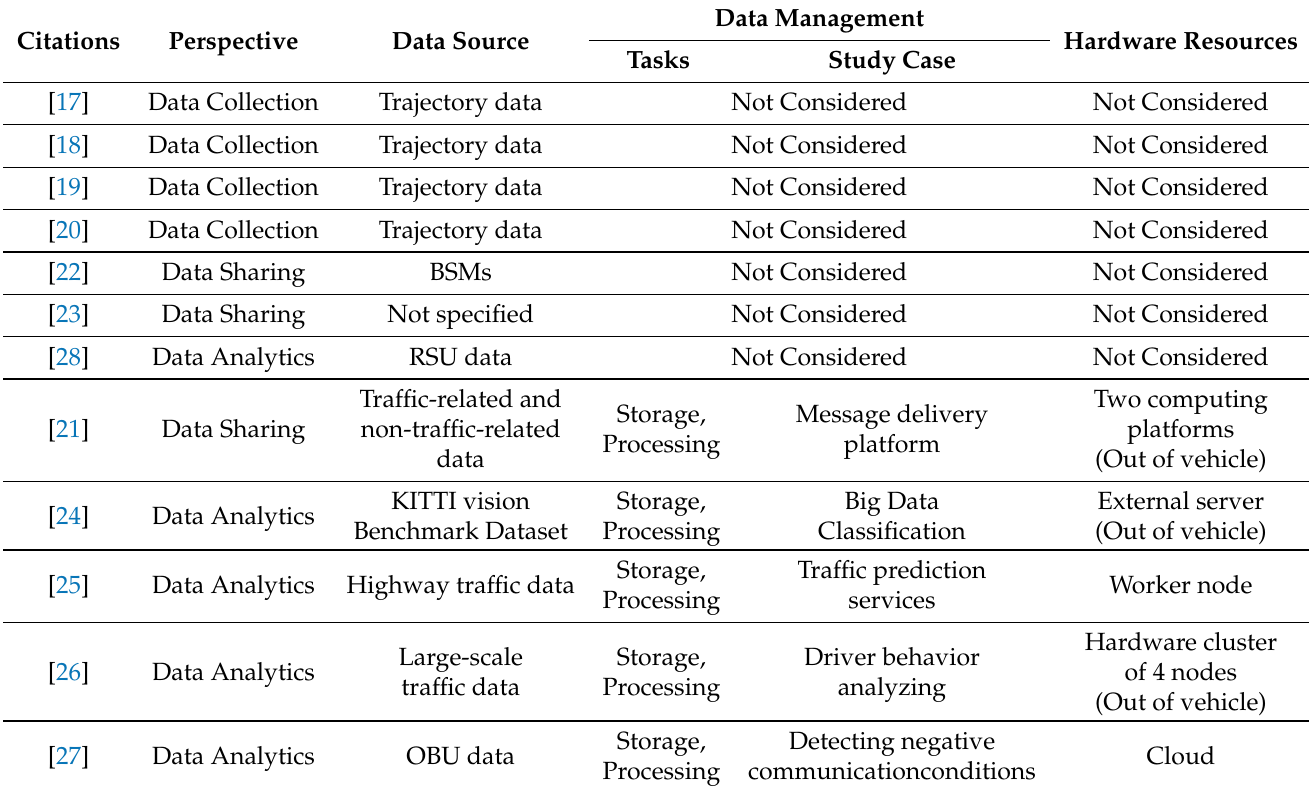
Table 1. Summary of related